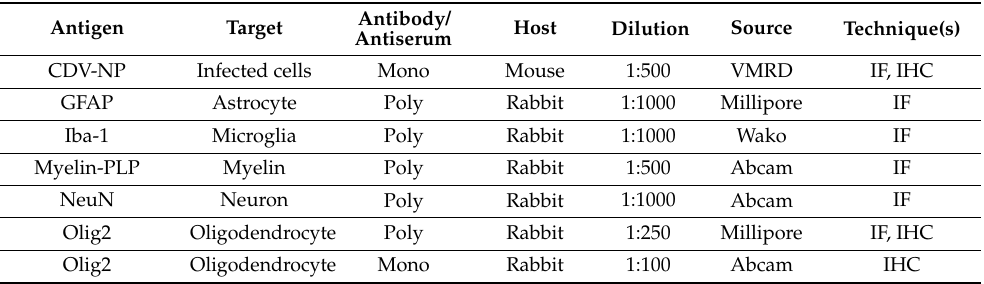
Table 1. Primary antibodies for neuropathological characterization in demyelinated/hypomyelinated areas by means of double IF and double